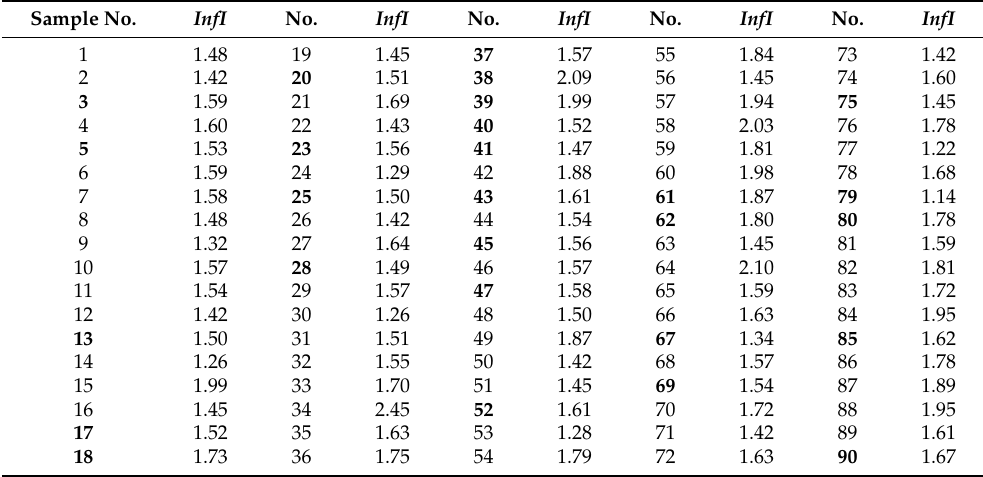
Table 6. Calculated value of infection indicator ( InfI ) for urine samples.